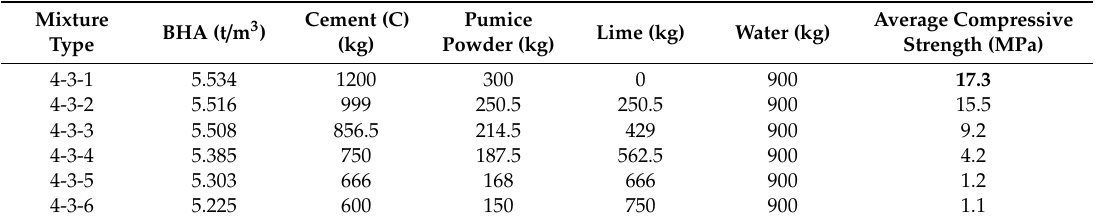
Table 27. Type-4-3 mixture quantity, weight per unit of volume and compression test